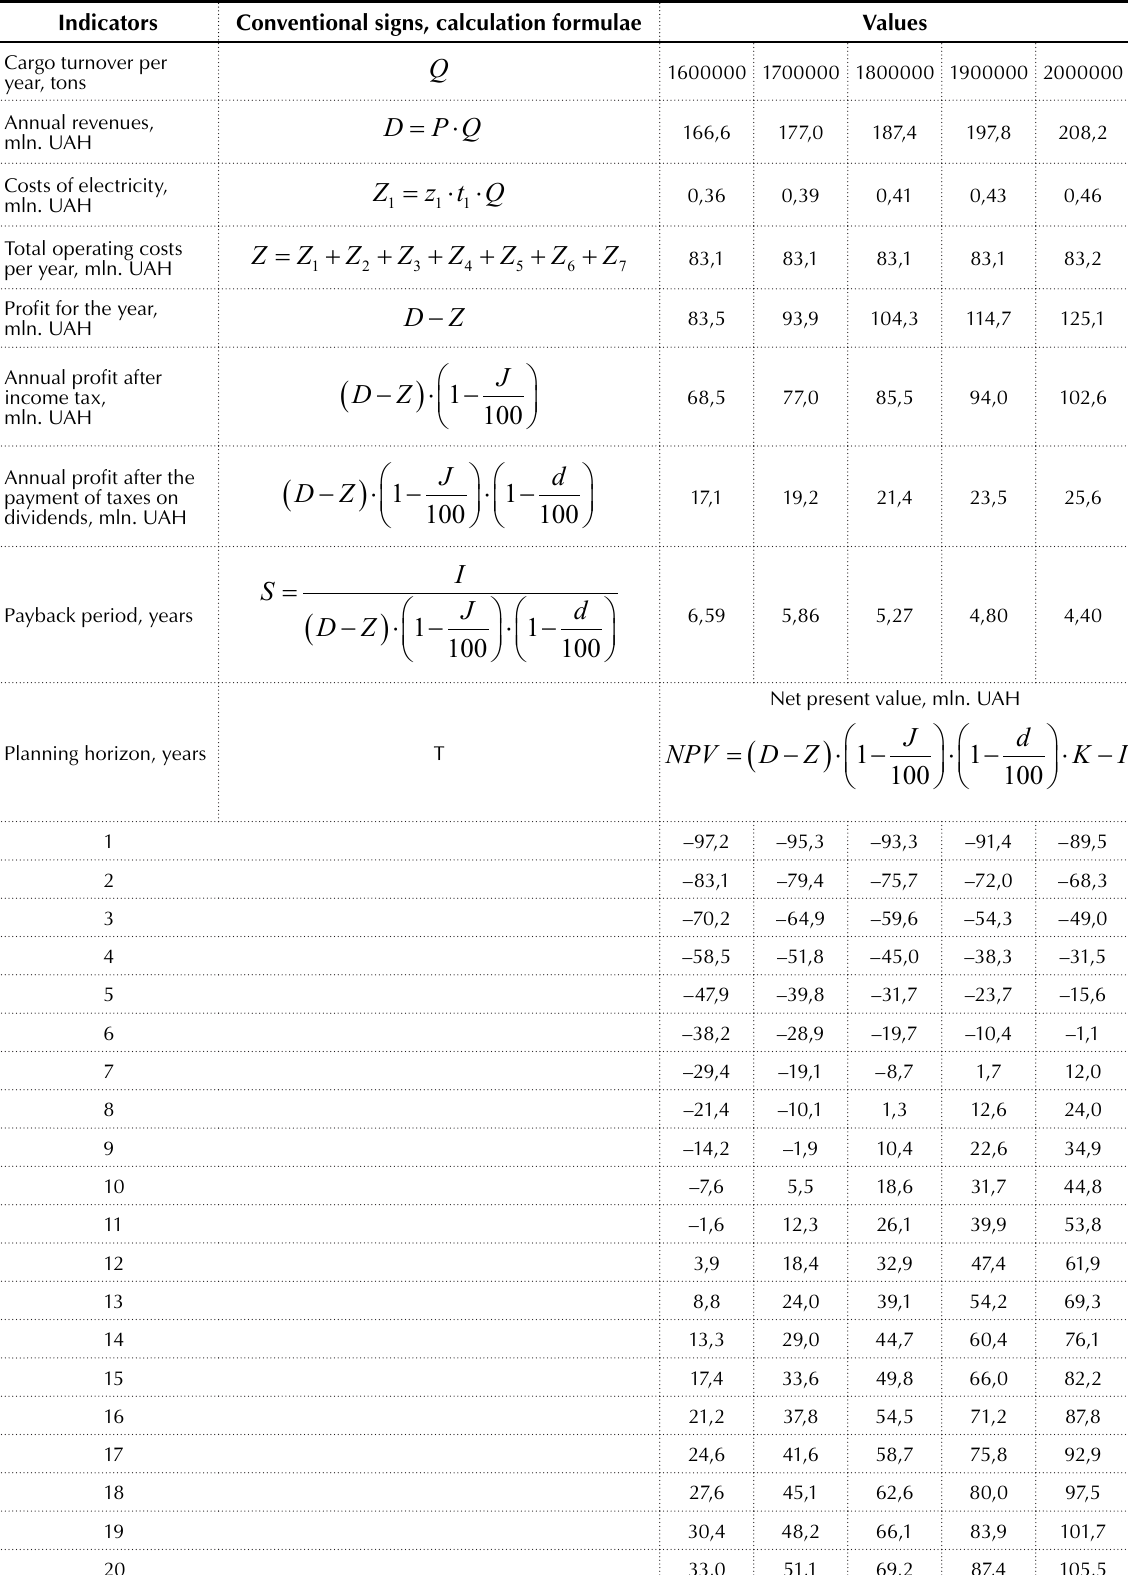
Table 1. The results of calculations of the indicators of economic effect from investment projects at the rate of dividend tax 75% d = and the values of cargo turnover from 1600000 to 2000000 tons